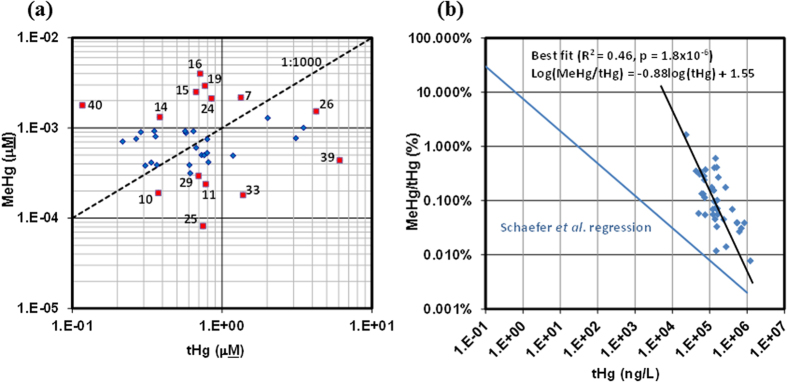
Correlation of MeHg to tHg in DWW.(a) Shown are log-transformed tHg and MeHg (μM) concentrations. Fourteen DWW samples with the highest and lowest MeHg/tHg ratios were selected for 16S rRNA gene pyrosequencing (red squares with sample number). Dashed line represents a MeHg/tHg ratio of 1:1000. (b) The comparison of the regression of MeHg/tHg versus tHg (in Schaefer et al., 2004)37 illustrates the high levels of tHg observed in the present study.